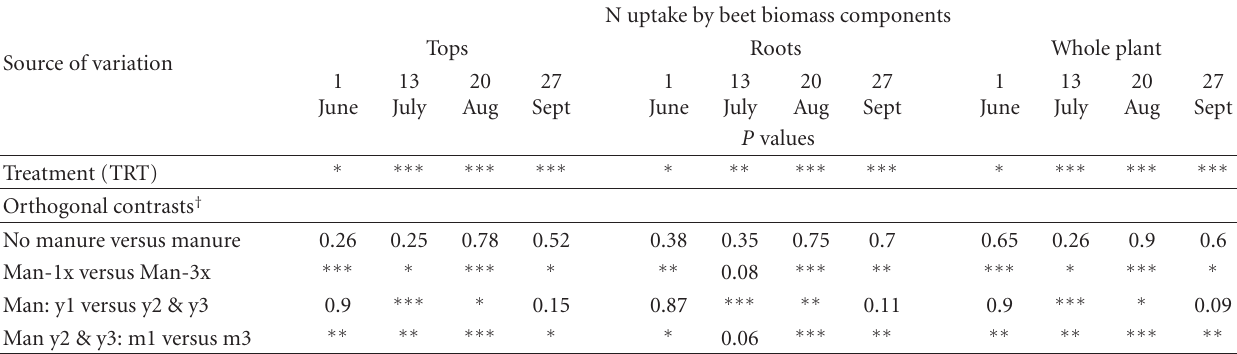
Table 3: The influence of treatment on N uptake in 2007 sugarbeet plant components. Table gives P values for treatment e ff ects, and single- degree-of-freedom orthogonal comparisons derived from an analysis of